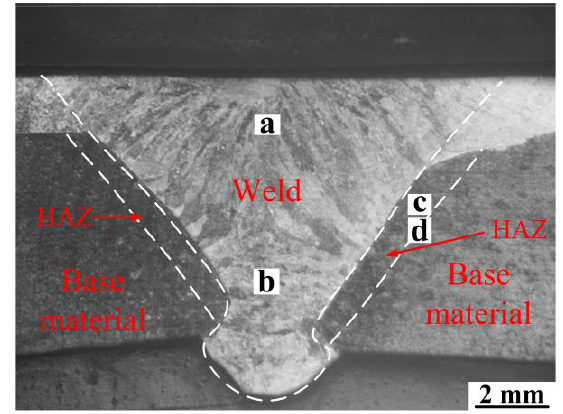
Figure 10. Macroscopic morphology of the welded joint.